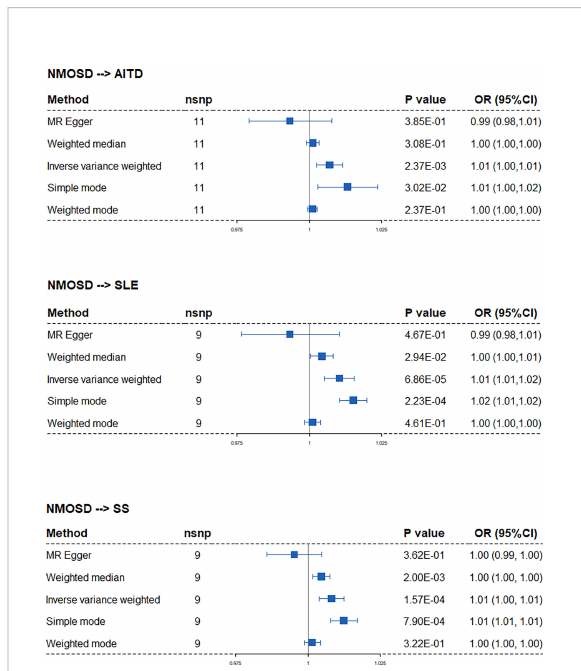
FIGURE 3 Forest plots of Mendelian randomization analysis that estimates the risk of AITD, SLE, and SS on the exposure of NMOSD. nsnp, number of causal SNPs; CI, con fi dence interval.